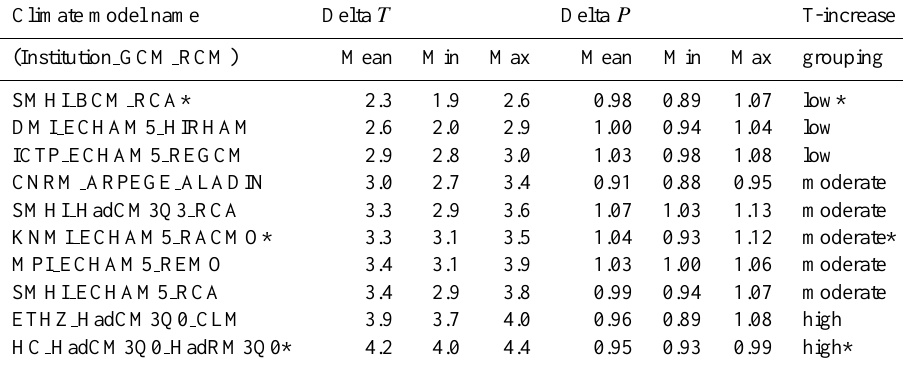
Table 1. Annual delta T and P for every climate model chain. The mean (MEAN), minimum (MIN) and maximum (MAX) values charac- terise the distribution of the catchment-specific annual change values. The precipitation change signal is given for additional information, but the grouping of climate model chains to the three different classes of mean annual temperature increase (low, moderate, high) is solely based on delta T